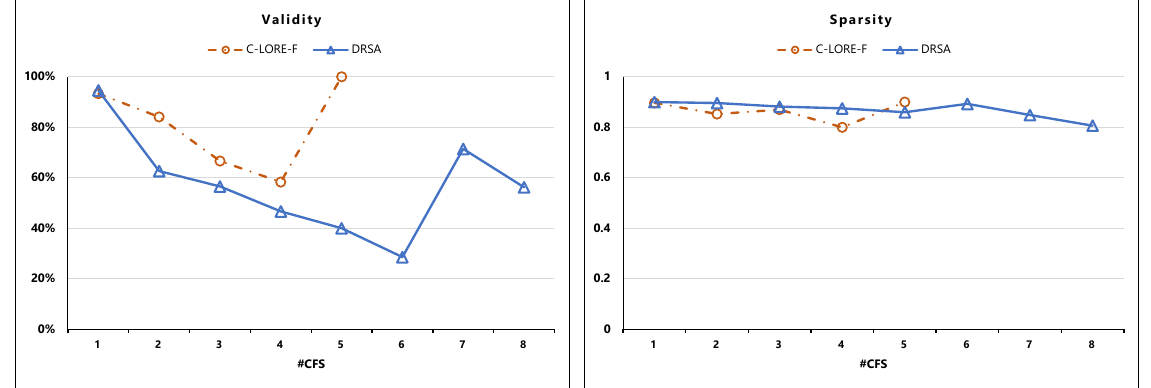
Figure 5. Validity and Sparsity of counterfactual examples. The numbers in the y -axis represent the metrics values (the higher values the better performance), while the x -axis represents the number of generated counterfactual instances.